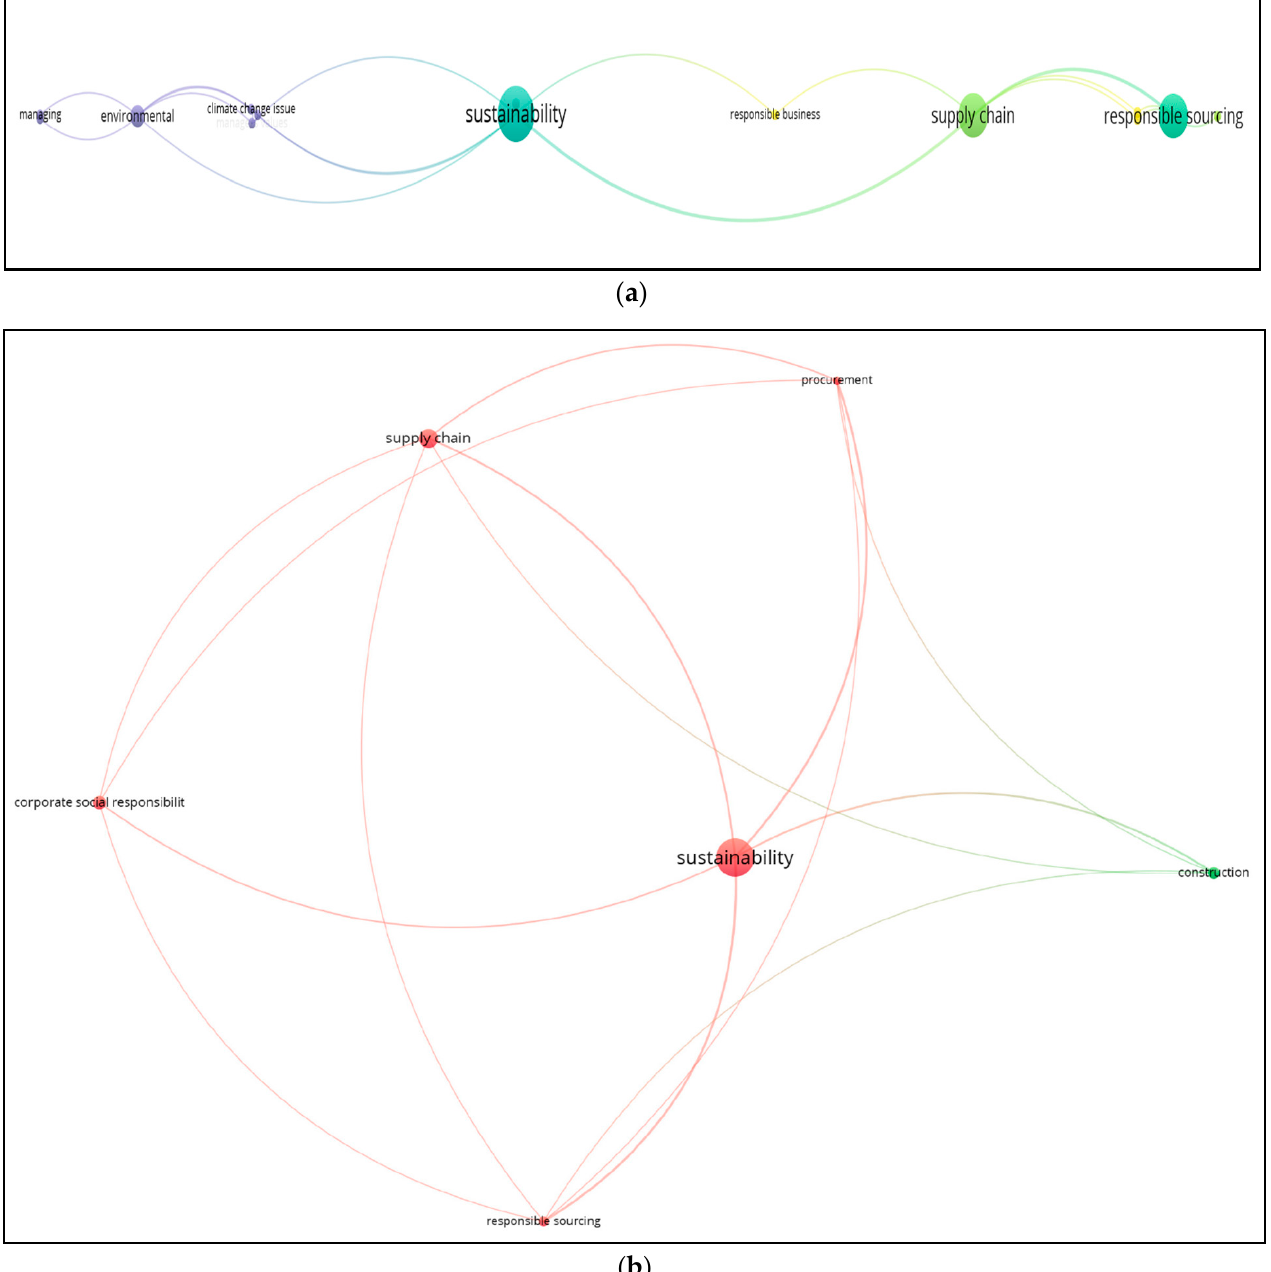
Figure 4. ( a ) Co-occurrence network of keywords presented in articles on the responsible source in the AEC sectors (from 2000 – 2020). ( b ) Co-occurrence network of keywords presented in articles on the responsible source in the AEC sectors (from 2000 – 2020).